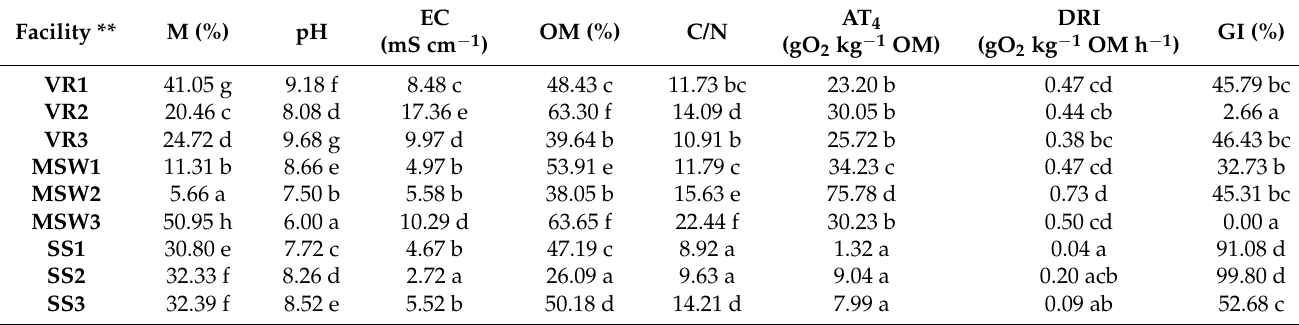
Table 3. Properties of final compost from industrial composting facilities